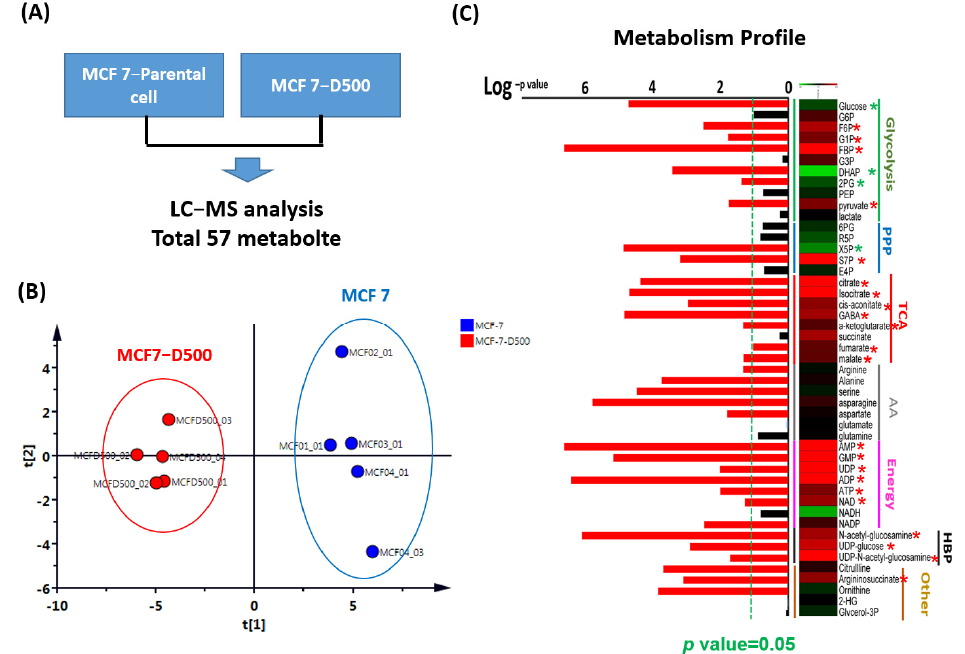
Figure 3. Metabolic profiles of MCF-7 cells with drug resistance examined through LC–MS. ( A ) The flowchart to identify the differential expression of metabolic products. ( B ) Principal coordinate analysis based on the number of metabolic products in all samples. ( C ) The heatmap of the selected principal component analysis from targeted metabolites in cells. The green dotted indicates p < 0.05 (* p < 0.05).